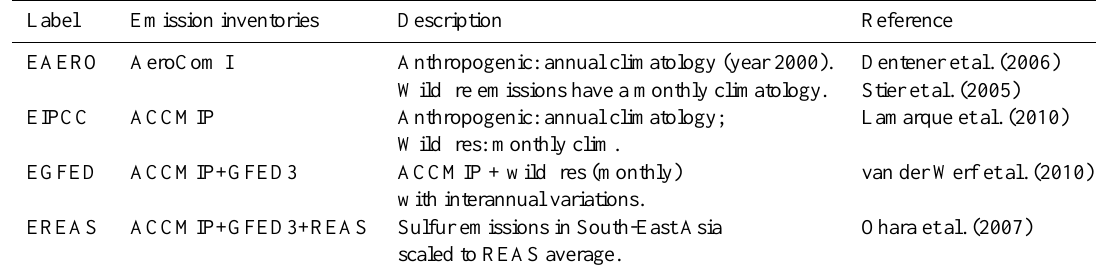
scaled to REAS average.